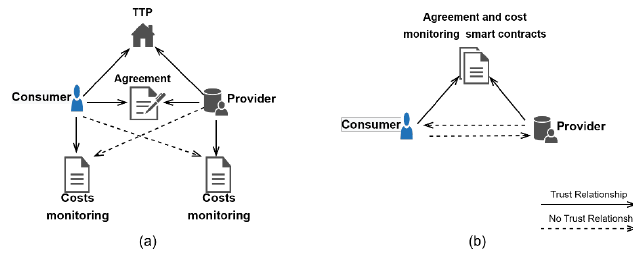
Figure 2: Trust relationship between actors.